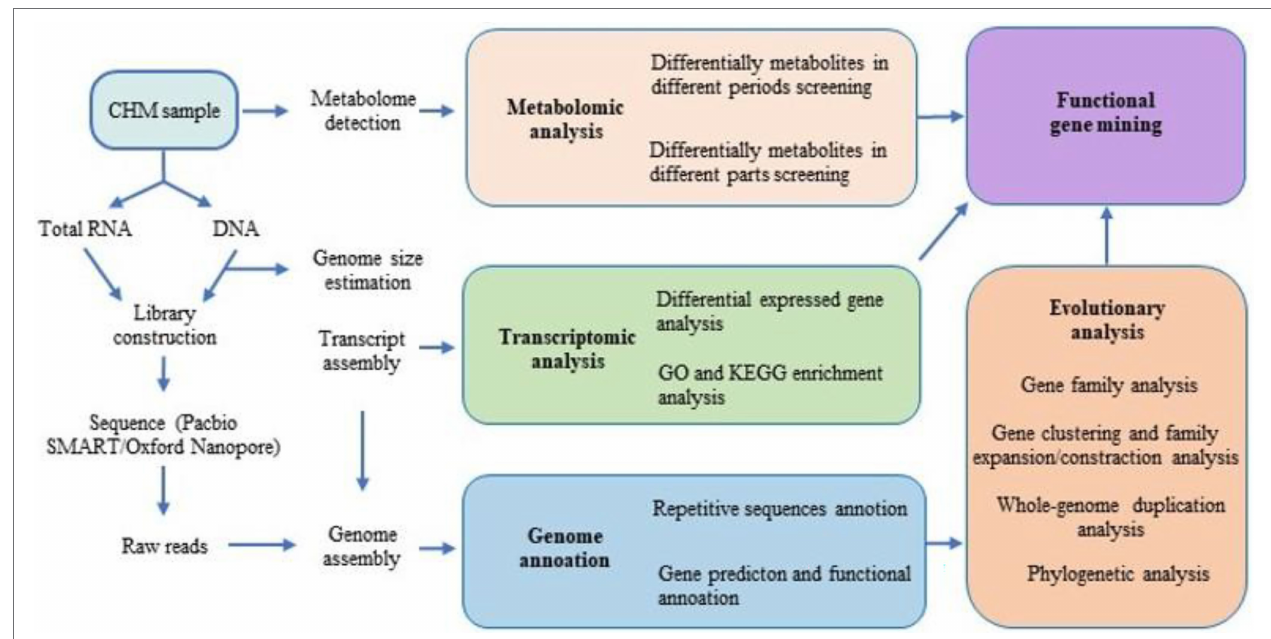
FIGURE 1 | Flow chart of bioactive compound related functional genes discovering based on high-throughput sequencing